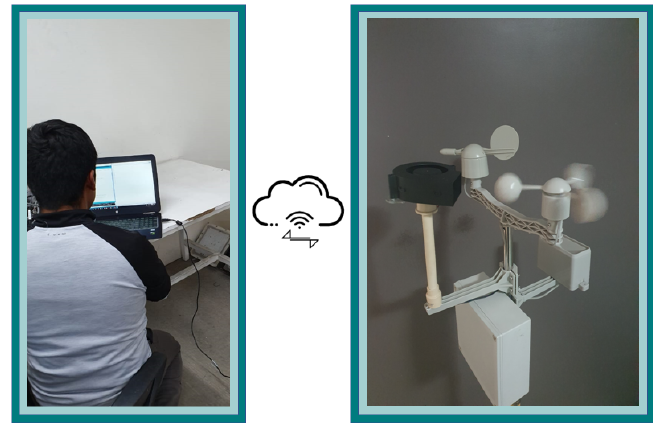
Figure 13. Concrete level: MEIoT weather station.